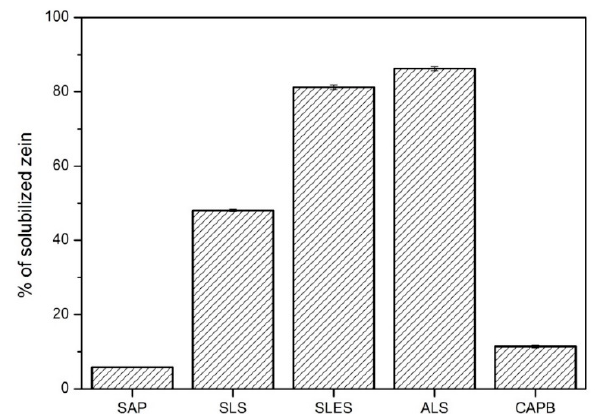
Figure 7. Percentage of solubilized zein in soapwort extract (SAP) or synthetic surfactants (SLS, SLES, ALS, CAPB), 5% concentration, after 1 h incubation with corn zein at 35